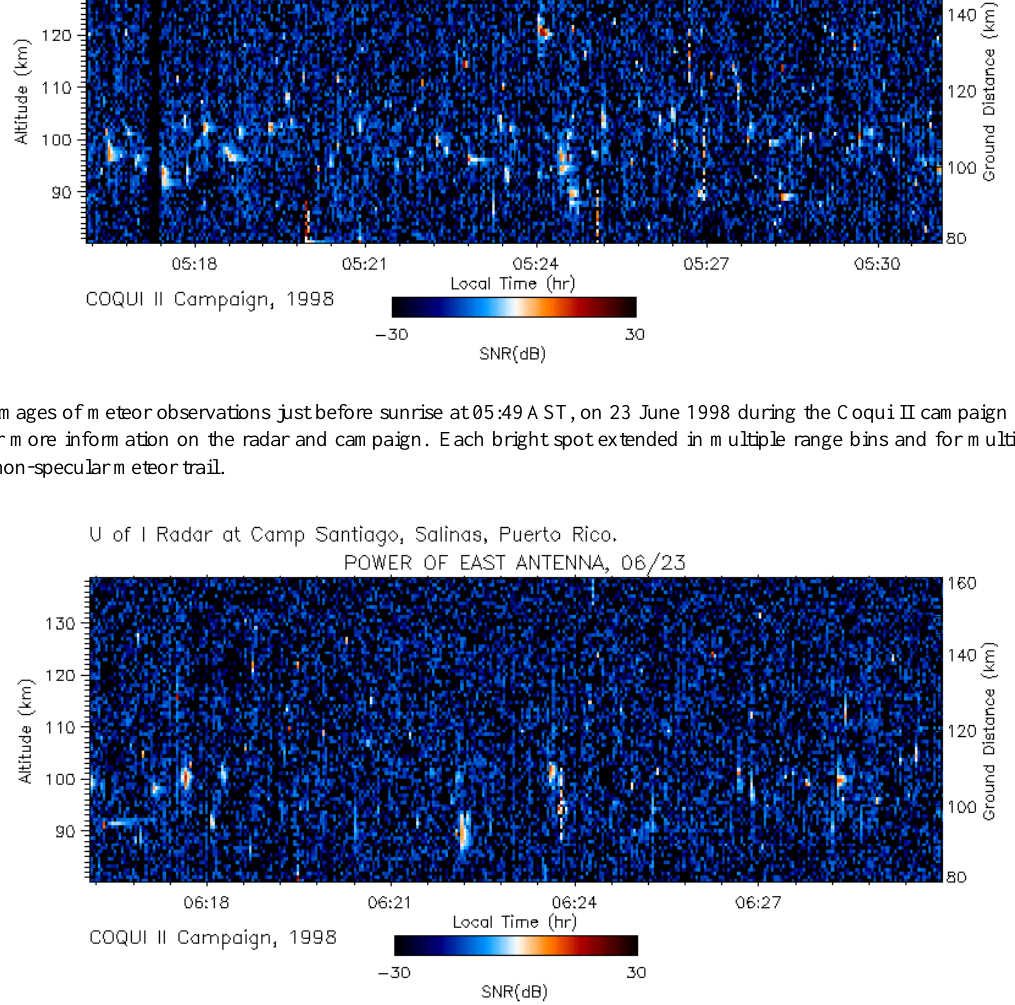
Figure 3. Meteor observations, in the same format as Figure 1, but shortly after sunrise, far fewer and Fig. 3. Meteor observations, in the same format as Fig. 1, but shortly after sunrise, far fewer and slightly shorter duration meteors were slightly shorter duration meteors were detected.